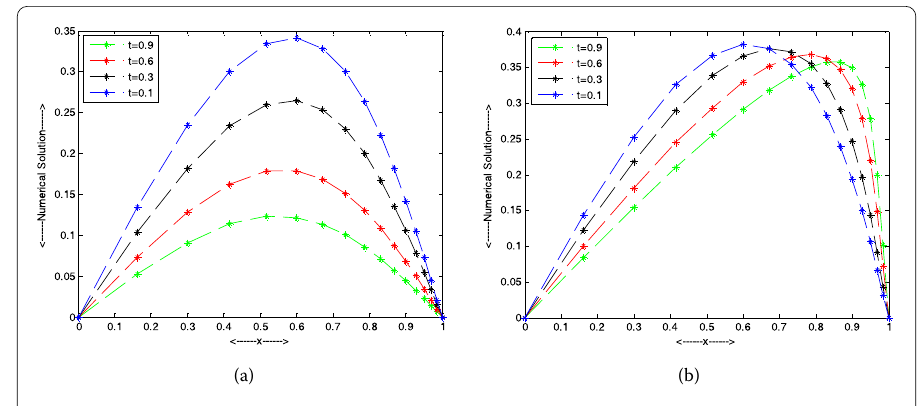
Figure 1 Example 2: Computed solutions for different time levels. (a) ε = 2 –3 , (b) ε = 2 –6 .